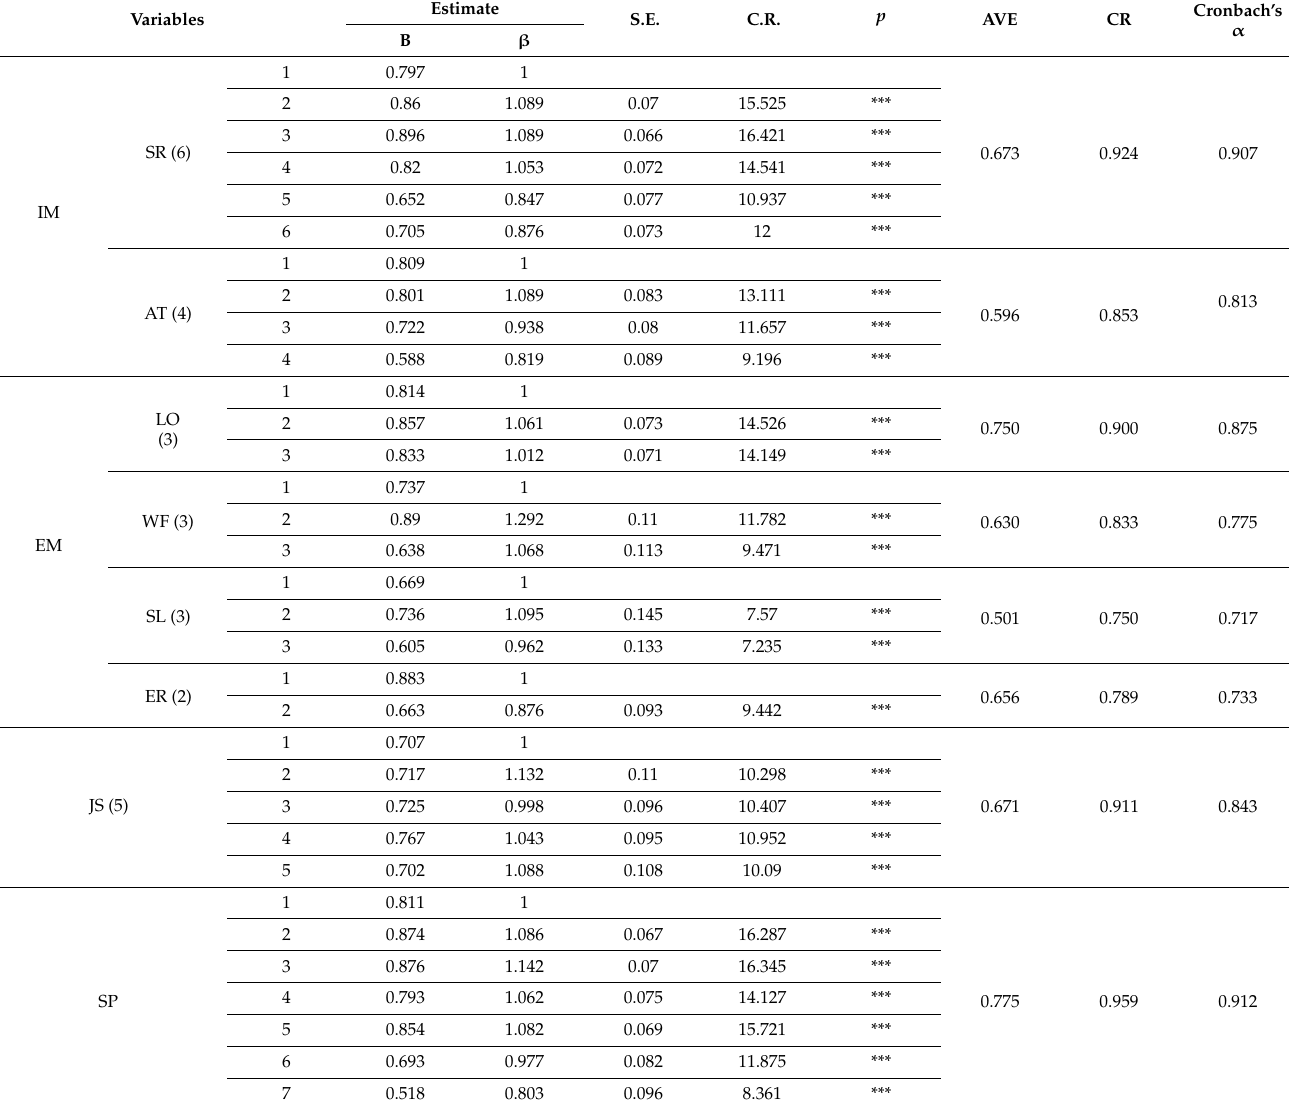
Table 3. Confirmatory factor analysis